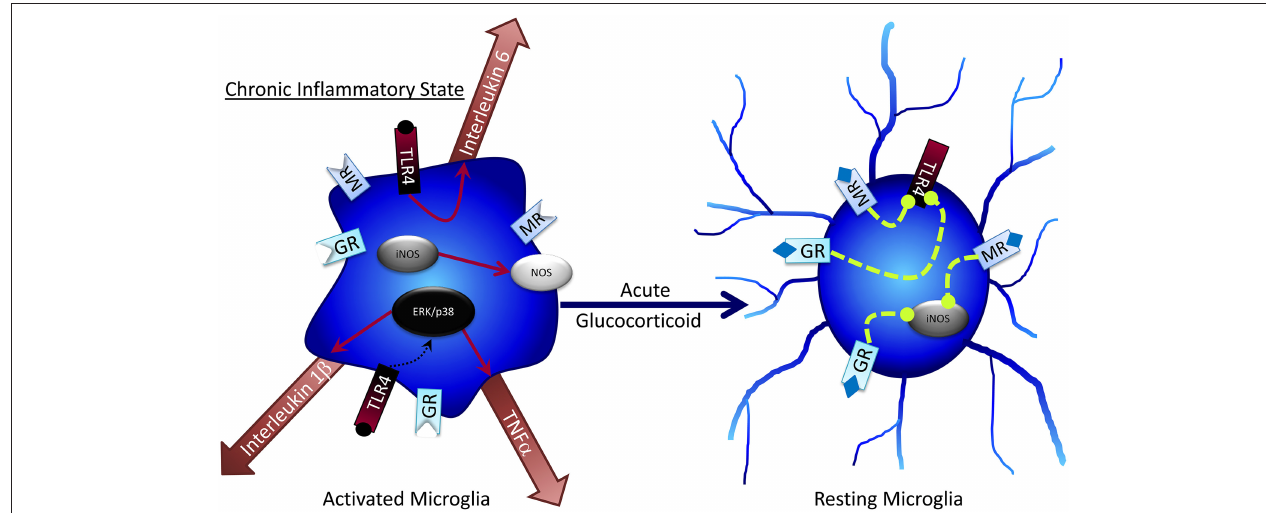
FIGURE 3 | Acute glucocorticoid exposure can return activated microglia to resting states.